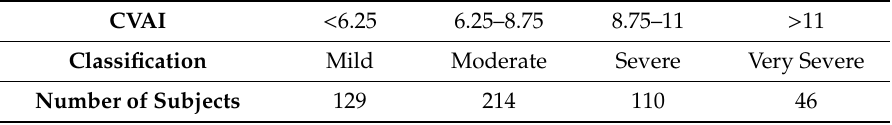
Table 1. Division of subjects within severity categories ( n = 499).